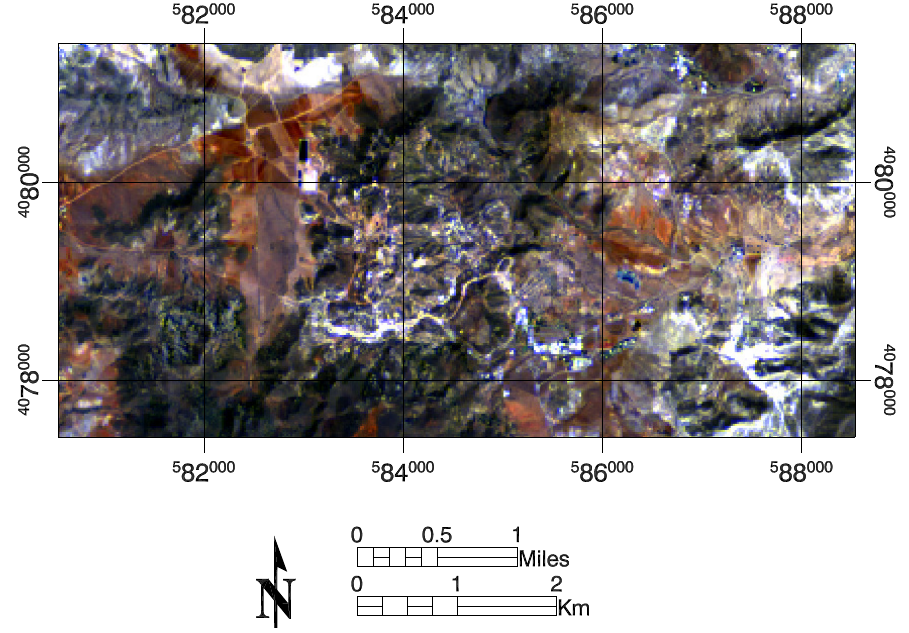
Figure 3. True colour composite of Sentinel-2A MSI bands 4 (in red), 3 (in green) and 2 (in blue). The image covers the 404 203 pixels subset of the study area around the mining town of Rodalquilar, × Cabo de Gata,